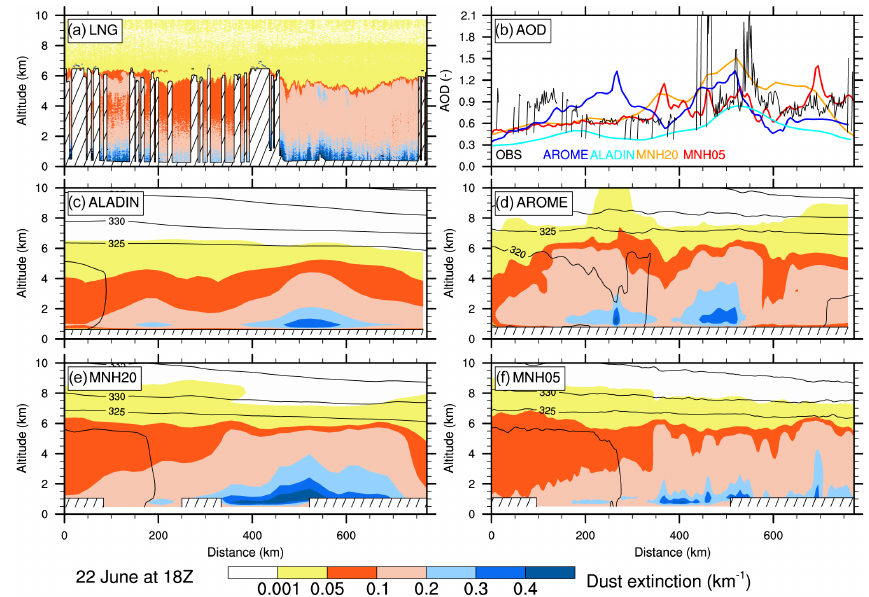
Figure 16. Same as in Fig. 12 but for the F25 flight on 22 June 2011. LNG observations were taken between 16:01 and 17:00UTC and forecasts are at